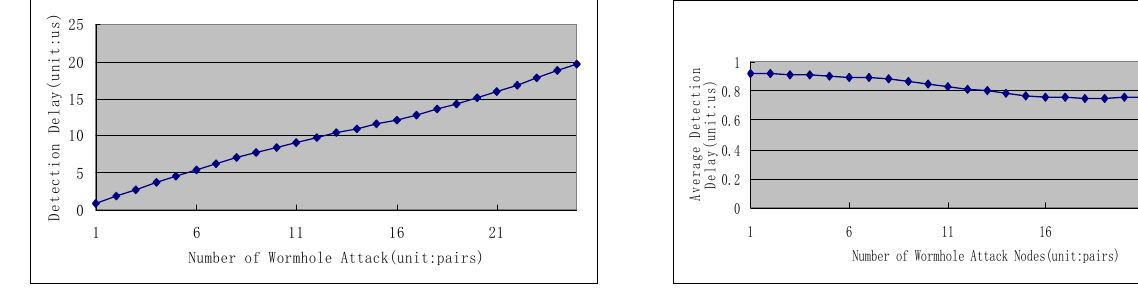
Fig.8. Average Detection